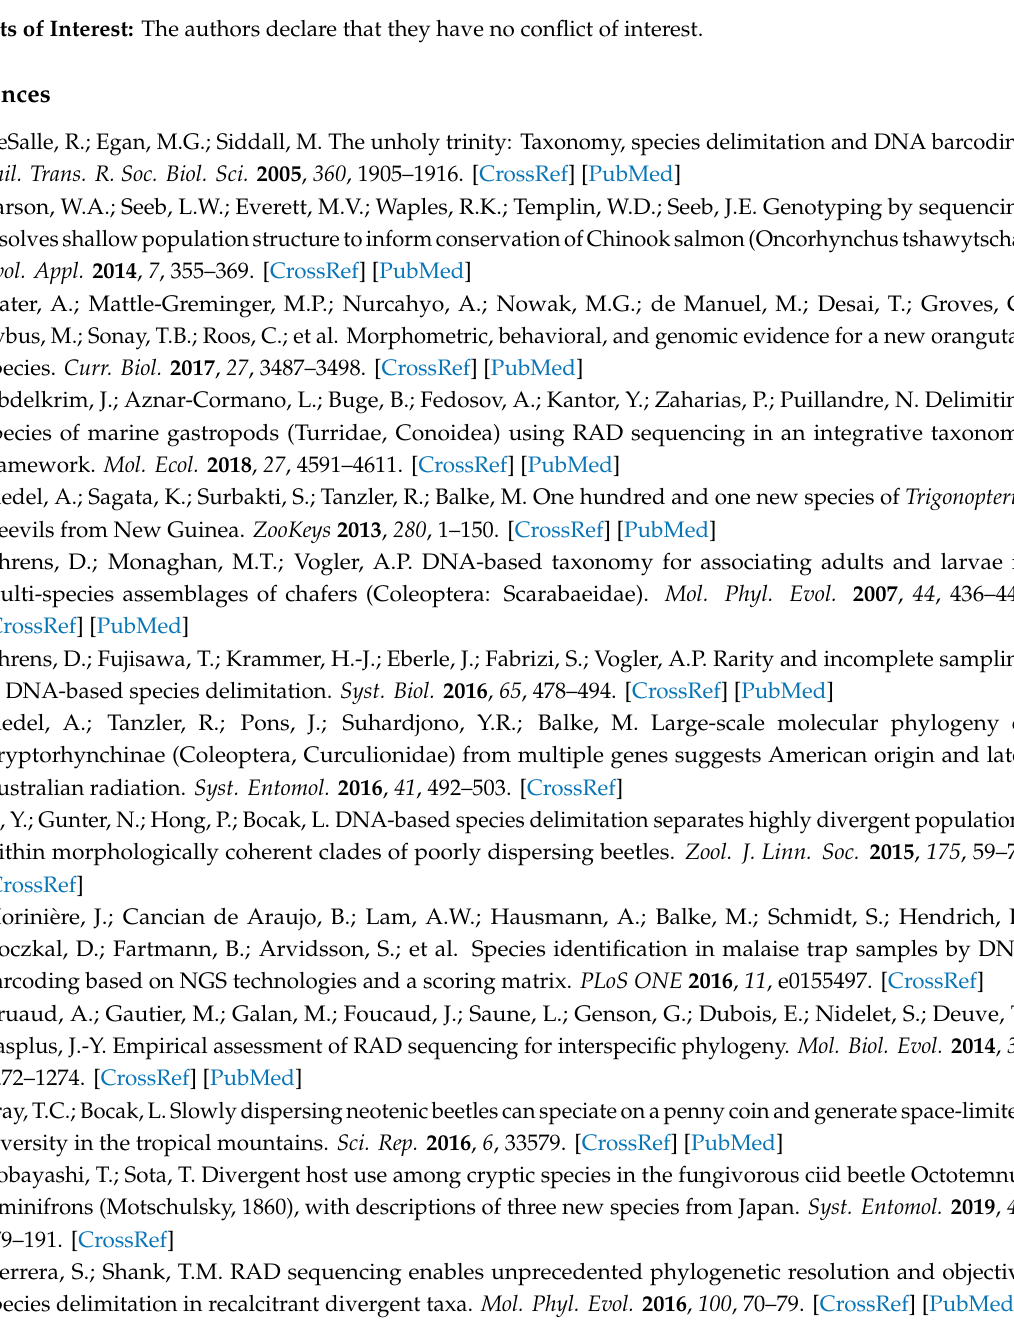
Table S1. The list of sampled localities with coordinates. Table S2. Euclidian distances among sampled localities in central New Guinea. Table S3. The list of primers used for mtDNA amplification. Table S4. Characteristics of datasets and best-fit models for mtDNA and nextRAD partitions. Figure S1. Topology recovered by the analysis of three mitochondrial DNA fragments, outgroups shown. Figure S2. The phylogenetic tree recovered by the analysis of cox1 mtDNA fragment. Figure S3. The phylogenetic tree recovered by the analysis of rrnL mtDNA fragment. Figure S4. The phylogenetic tree recovered by the analysis of nad5 mtDNA fragment. Figure S5. Bayesian Poisson Tree Process species delimitation using cox1 mtDNA data (reprinted from Bocek & Bocak 2016). Author Contributions: L.B. designed this study. M.B., D.K. and M.M. performed bioinformatic analyses